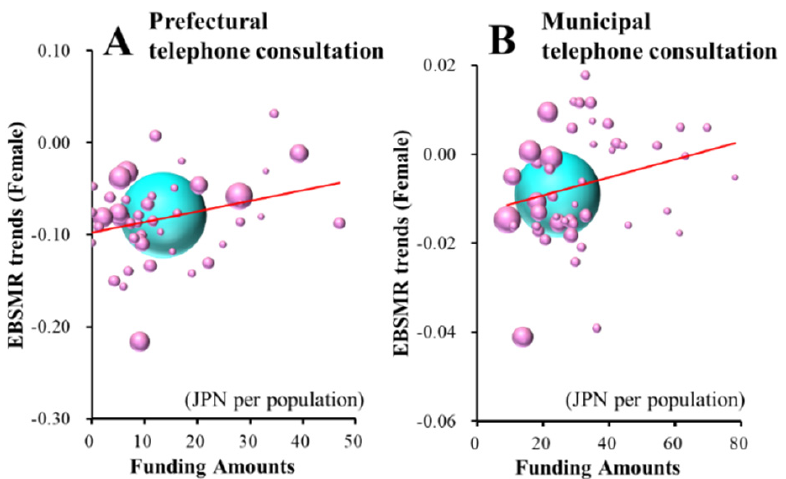
Figure 4. Effects of the amount of funding provided to sub-divisions of EFECBSC on female EBSMR trends of suicide mortalities caused by family- ( A ) and school-related ( B ) motives were analysed by forward multiple regression analysis. Ordinates indicate EBSMR trends of suicide mortality caused by family- and school-related motives between 2009 and 2018, and abscissas indicate the amount of funding provided to EFECBSC sub-divisions (JPY per population). Light blue and red spheres indicate national and female EBSMR trends and population sizes, respectively. Red lines indicate the regression lines of significantly negative (increases suicide mortality)